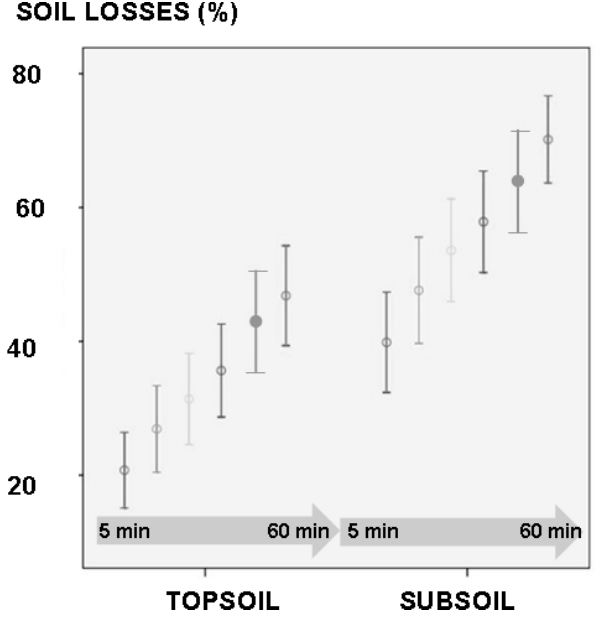
Fig. 2. Soil losses (%) for topsoil and subsoil samples ( n = 41 each). The lines represent average values ± 2 standard error. Wet sieving was performed for 6 sieving times (5, 10, 15, 20, 40, 60 min.).